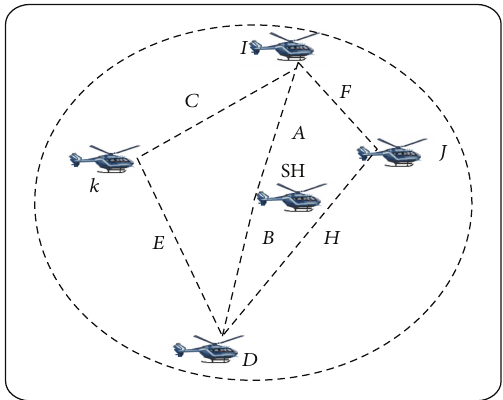
Figure 3: Information routing inside